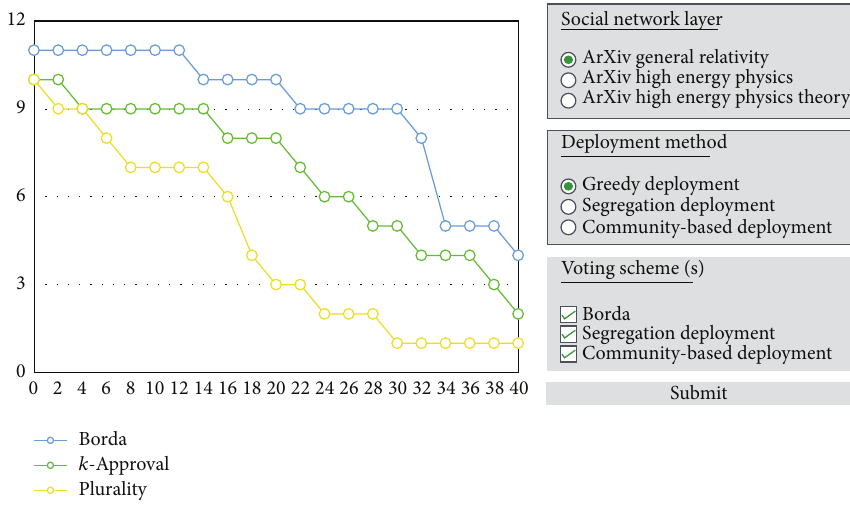
Figure 3: Our user-interface for the convenience of doing experiments.